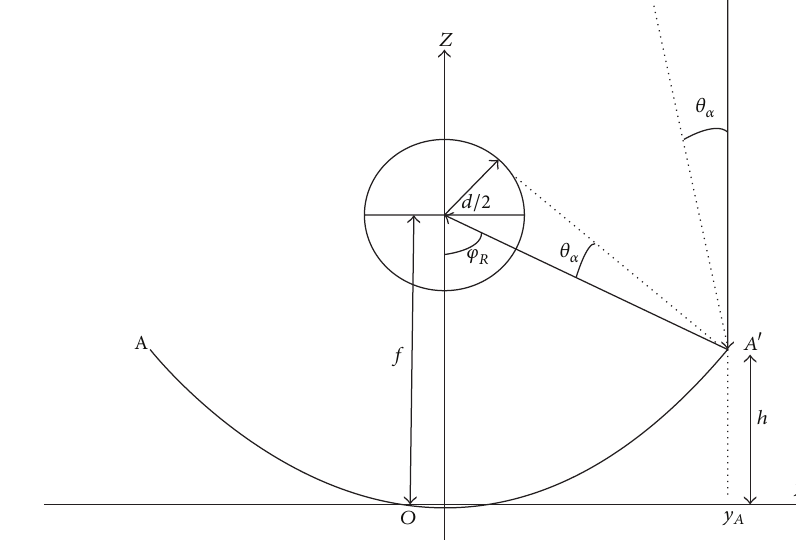
Figure 3: Schematic view of the parabola.